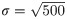
Phase space plot shows a marked difference of signals originating from poisson vs. normal distribution.a) Time waveform of a model signal with Poisson distribution (λ = 500, n = 3000); b) its depiction in the phase space and a close-up view of its central part. c) Time waveform of a model signal with normal distribution (μ = 500; σ=500, n = 3000); d) its depiction in the phase space and a close-up view of its central part.